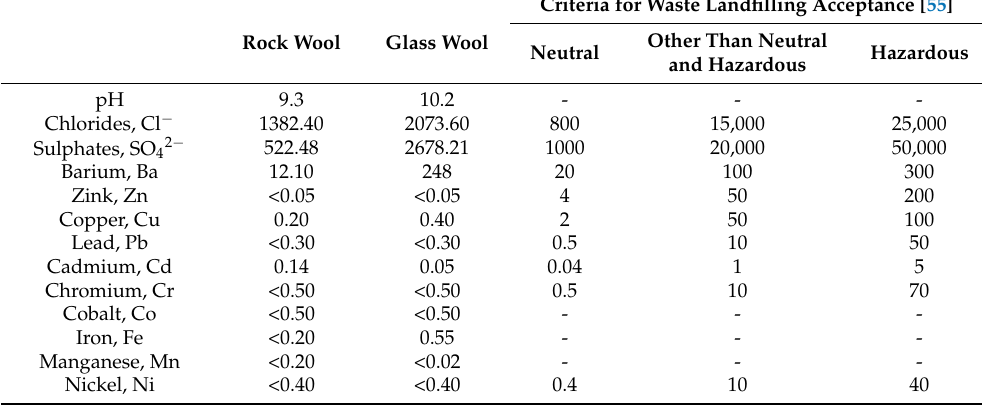
Table 4. Leachability of harmful substances and heavy metals from the tested mineral wool, expressed in mg/kg dry weight (except for pH).